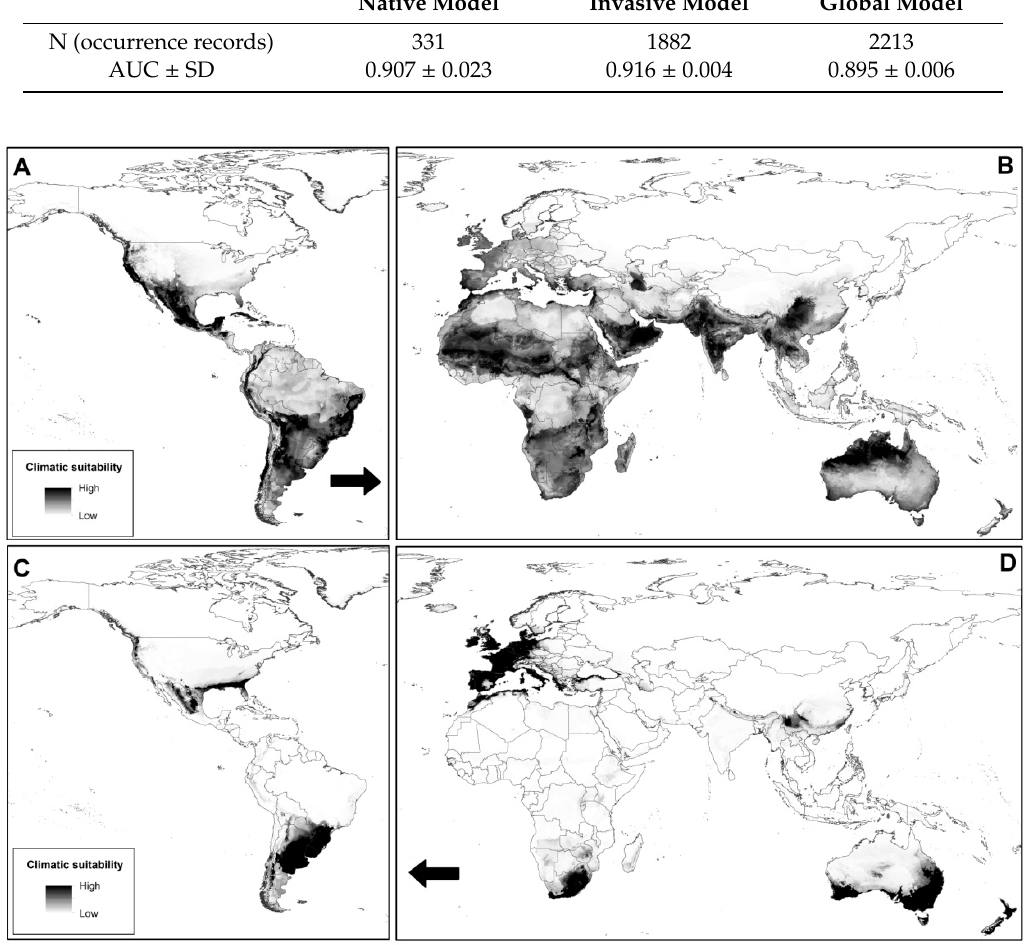
Figure 3. Current potential distribution of Azolla filiculoides based on reciprocal models. ( A ) Model calibrated with native occurrences and ( B ) model projected onto the invasive range. ( C ) Model projected onto the native range and ( D ) model calibrated with invasive occurrences. Darker shades indicate higher environmental suitability. Arrows indicate the direction of model projections. Table 1. The table shows the number of occurrence records (N) was used for building the different models and the AUC values and standard deviation for Azolla filiculoides models performance.